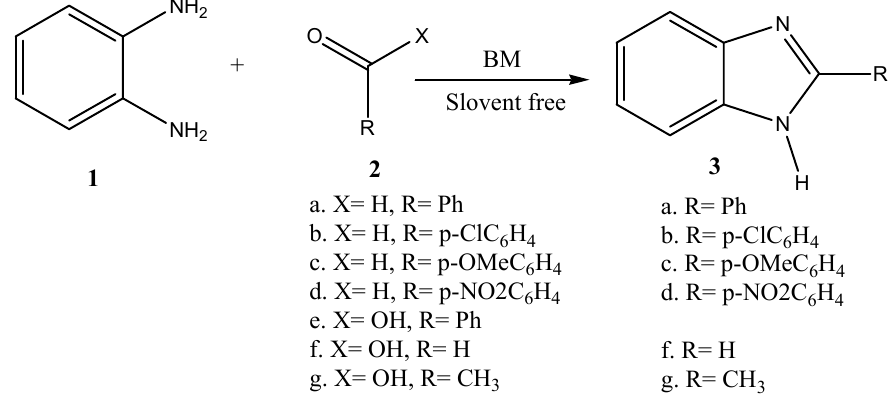
Table 6. Milling of 2.5 g of benzimidazol-2-one, 2 g sodium hydride and 5.0 g of ethyl chloroacetate with 56.6 g of balls at 20 Hz.